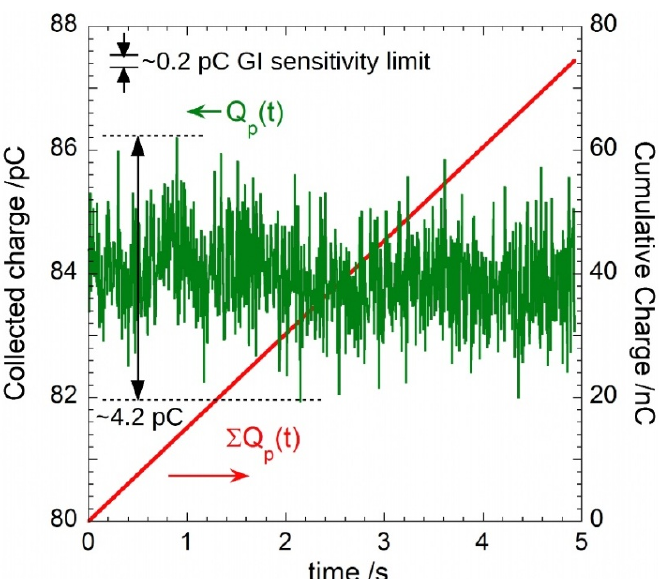
Figure 11. Charge-per-pulse (in green) and cumulative charge (in red) measured by the proposed GI prototype.